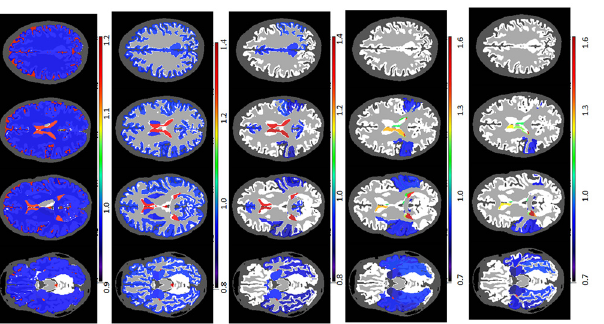
Fig 11. Differences in regional volumes between AD and controls at each granularity level. The colors code the ratio of volumes in AD/controls in regions of significant difference (P value < 0.05, Bonferroni- corrected). Blue (ratio < 1) represents regions of atrophy in AD, while green/yellow/red are regions that are bigger in AD, such as the